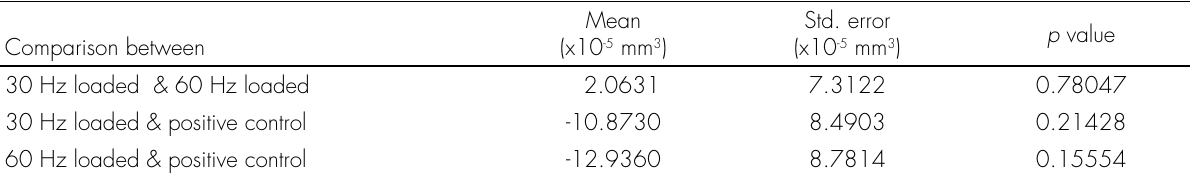
Table II. Student t -test comparing the volume of root resorption crater in loaded molars between different vibration groups. Comparison between